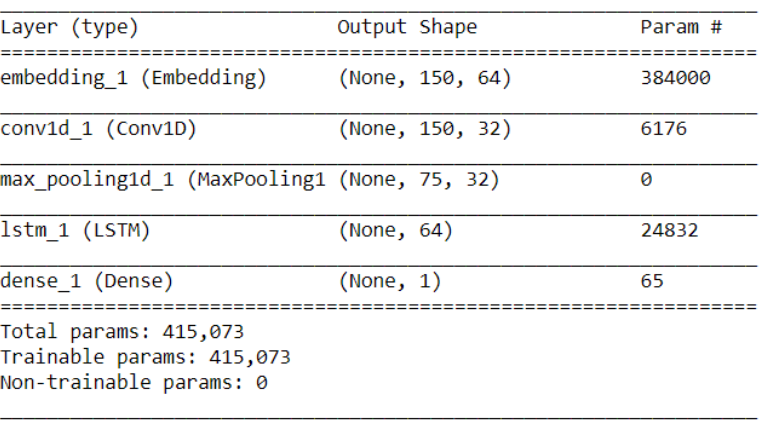
Figure 6. Parameters of LSTM architecture.